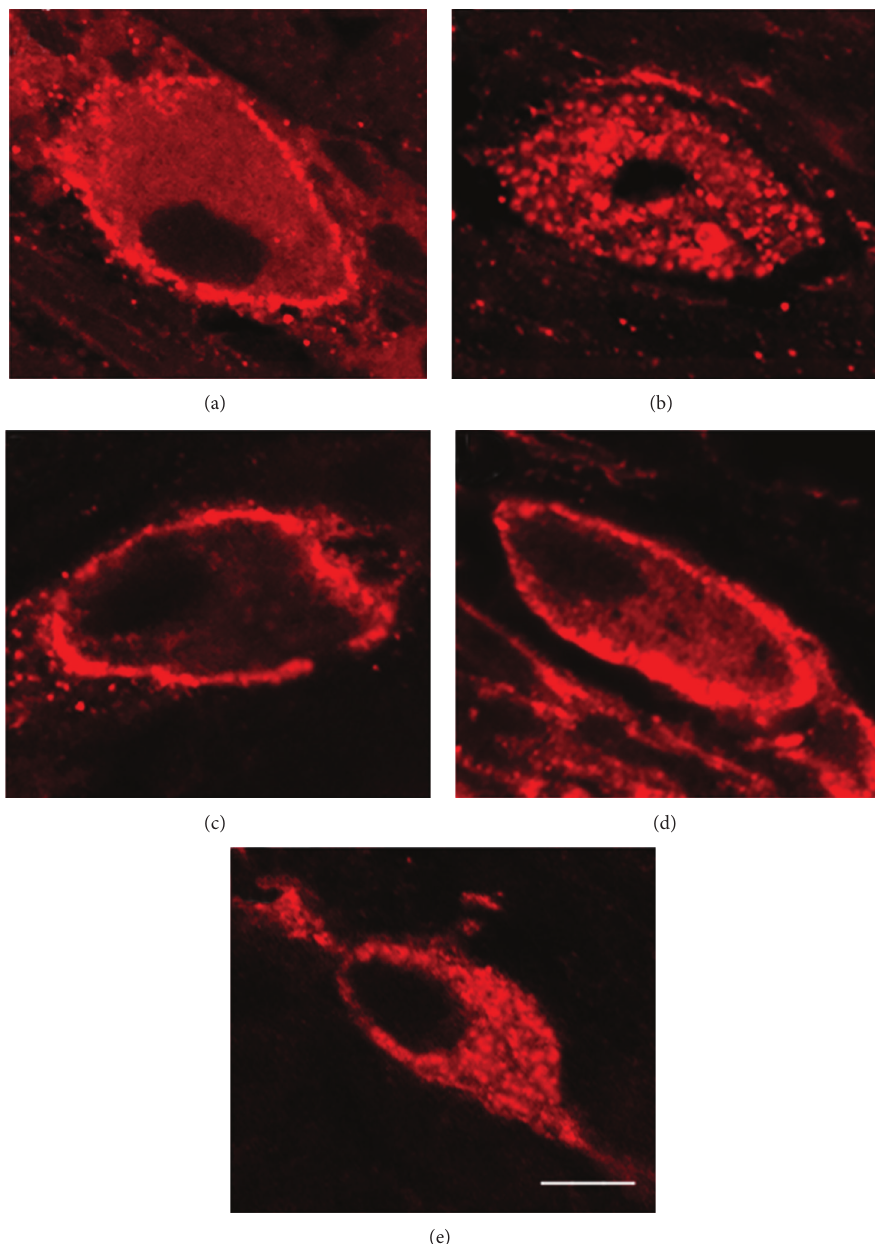
Figure 5: The effects of sulfasalazine, 5-ASA, and sulfapyridine on toxin A-induced substance P release in the colon. Laser scanning confocal fluorescent micrographs of neurons immunostained for the NK-1R from colonic segments treated for 3 h with (a) vehicle, (b) 5 𝜇 g toxin A, (c) 5 𝜇 g toxin A after 5 days of treatment with sulfasalazine (100mg/kg ⋅ day), (d) 5 𝜇 g toxin A after 30 minutes of intraluminal pretreatment with 5-ASA (100 𝜇 g), and (e) 5 𝜇 g toxin A after 30 minutes of intraluminal pretreatment with sulfapyridine (100 𝜇 g). Bar, 5 𝜇